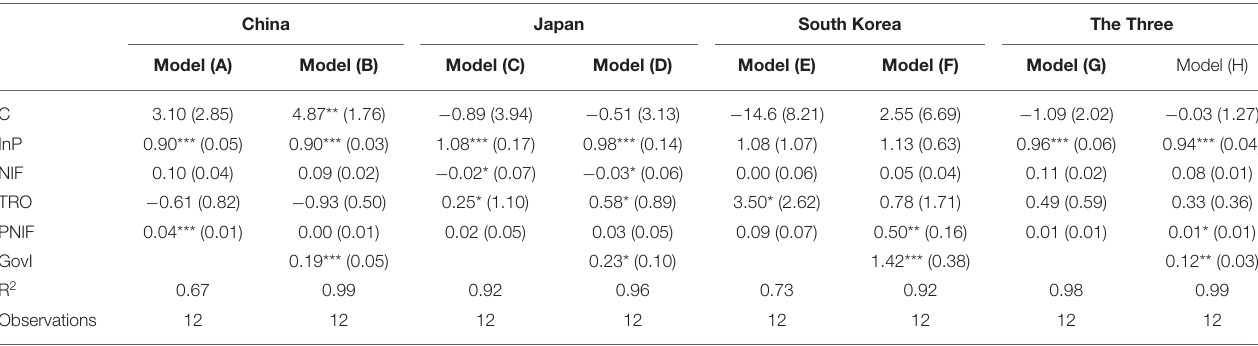
TABLE 4 | Estimated results on